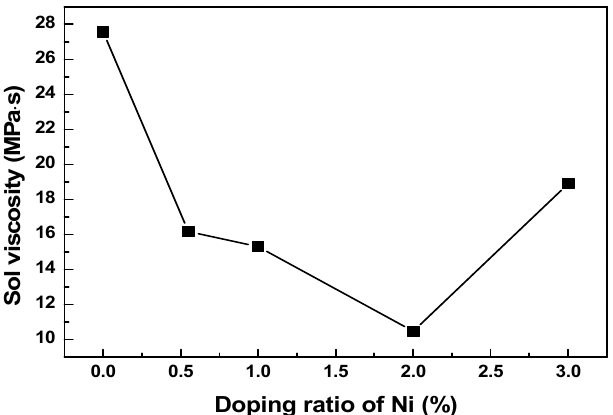
Figure 1. The sol viscosity of sol doped with different mass ratios of Ni at 87 h.